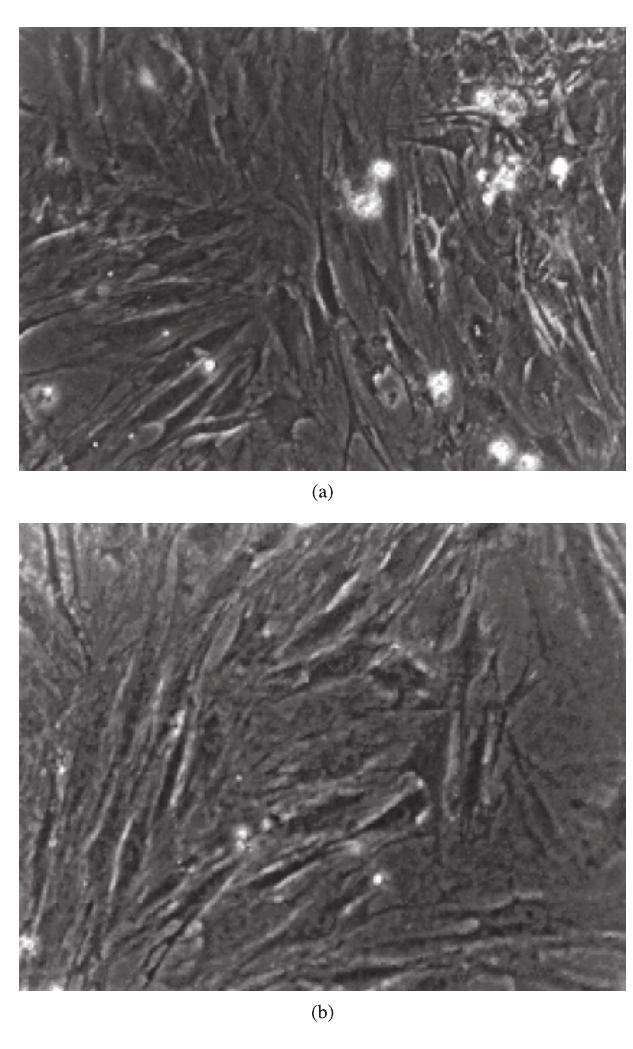
Figure 5. Osteoblast cell culture: a) cells cultured in contact with the biomaterial; b) cells cultured on tissue culture polystyrene (TCPS -